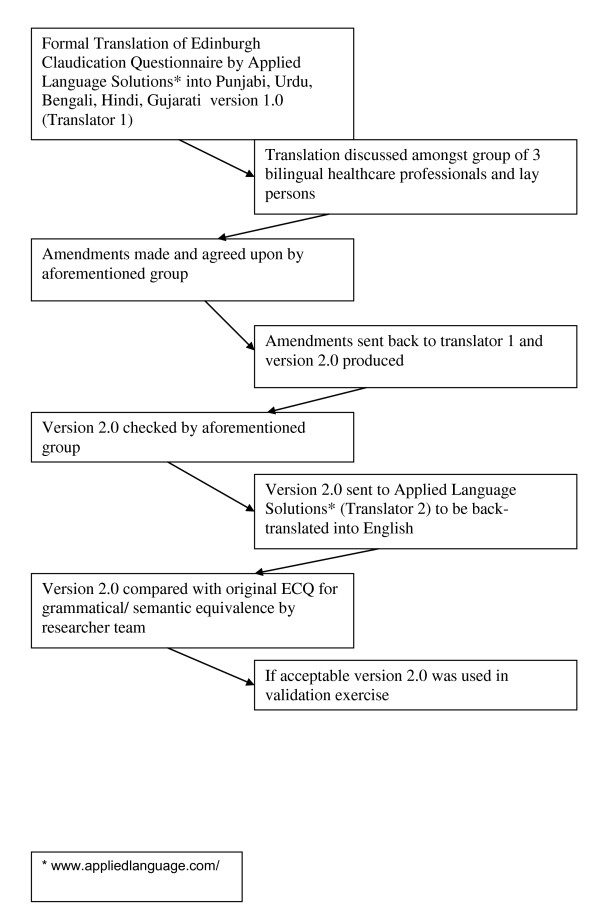
Translation process of the Edinburgh Claudication Questionnaire.